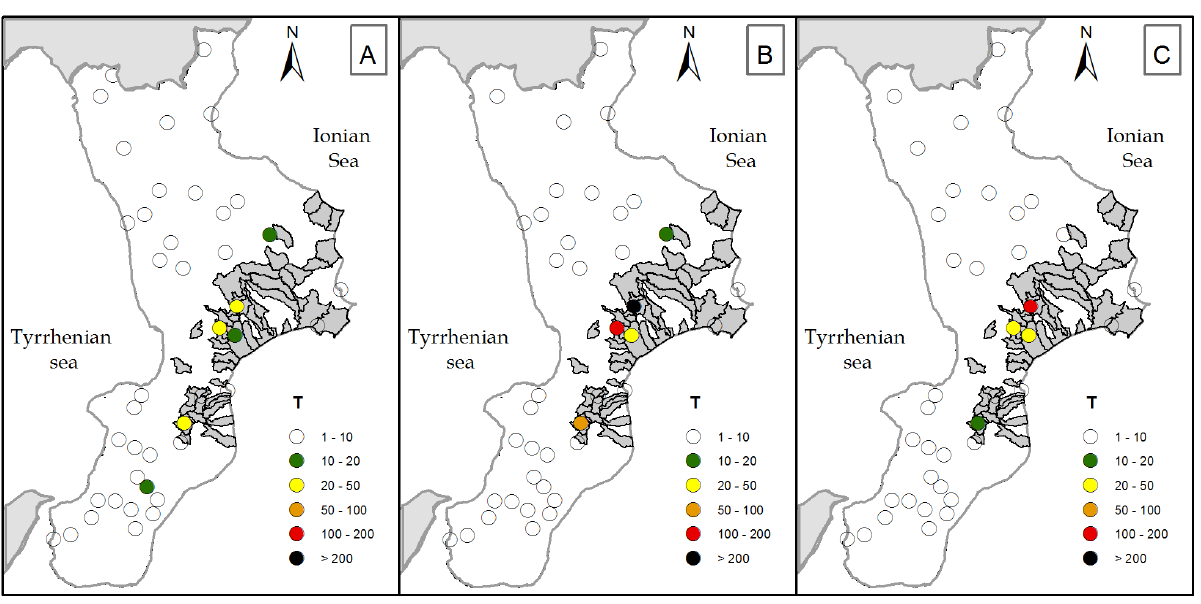
Figure 8. Return period ( T ) of maximum hourly rainfalls with duration of ( A ) 1; ( B ) 3; and ( C ) 6 h registered on 19 November 2013 overlapping the map of the damaged municipalities. Different colors indicate different ranges of T , according to the